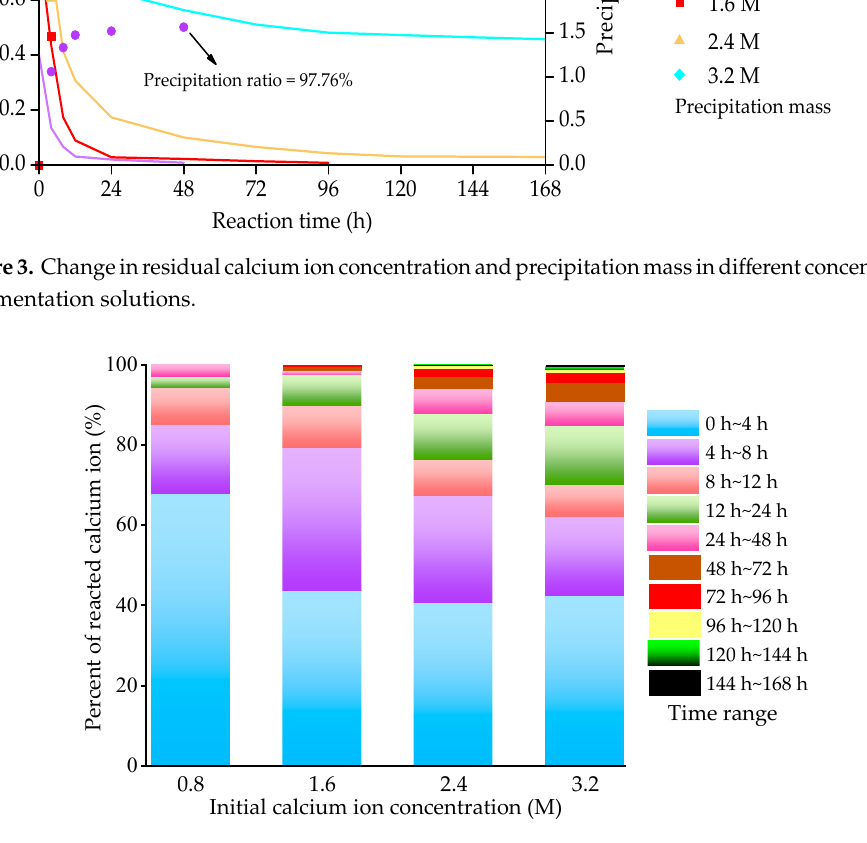
Figure 4. Calcium ion ratio that reacted in each sample at different times.